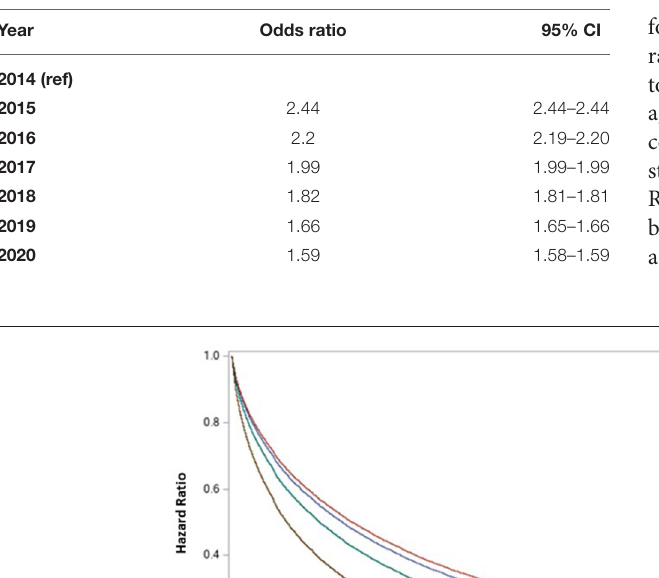
2014 (ref) to 2020.